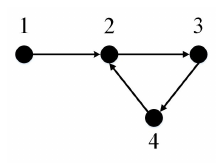
Figure 1. The network